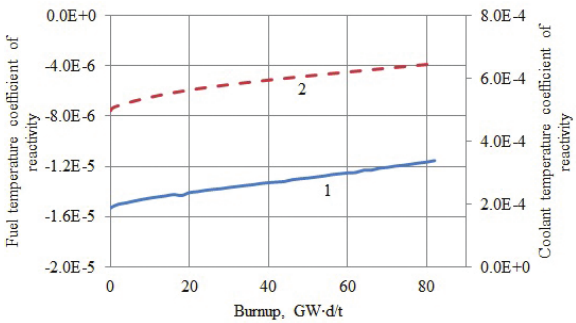
Figure 7. Changes in the reactivity coefficients forf the fuel composition containing 35% of 235 U + 65% of 237 Np during the campaign: 1) fuel temperature coefficient of reactivity; 2) cool- ant temperature coefficient of reactivity.